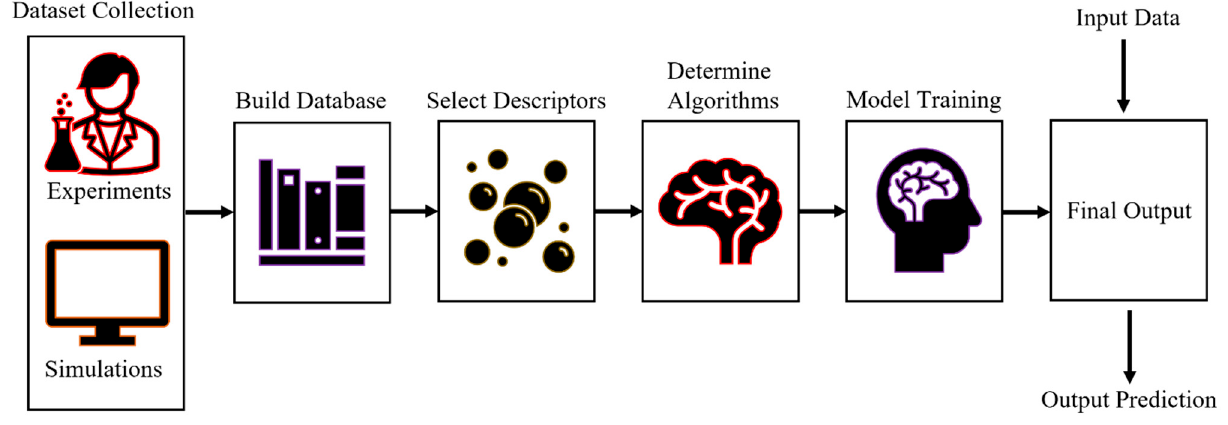
Figure 2. Process of DL